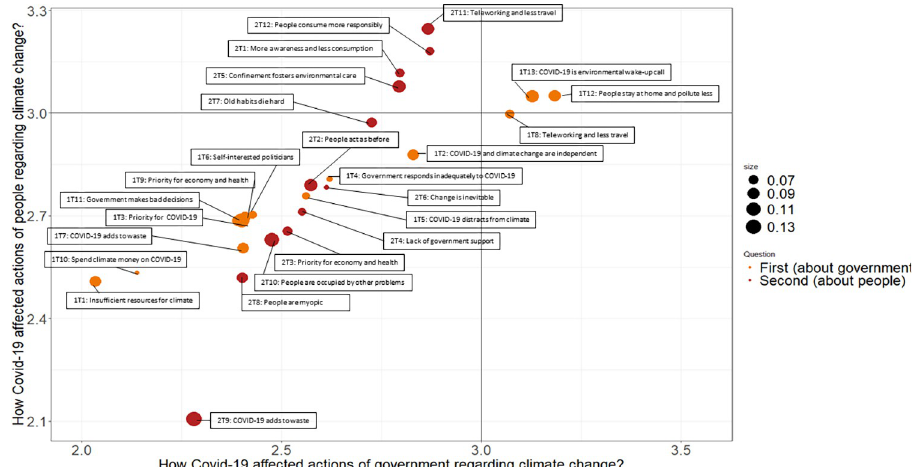
Fig 3. Optimistic vs pessimistic views on actions of government and people with regard to climate for all topics generated. Note: Orange color indicates topics from the first open question (about climate actions by the government), and red from the second one (about climate actions by the people). Size of the topic reflects its prevalence in the overall set of responses. Position of each topic on the X- and Y-axes is the weighted average response on the Likert scale from 1 (very negatively) to 5 (very positively) on the corresponding closed questions.